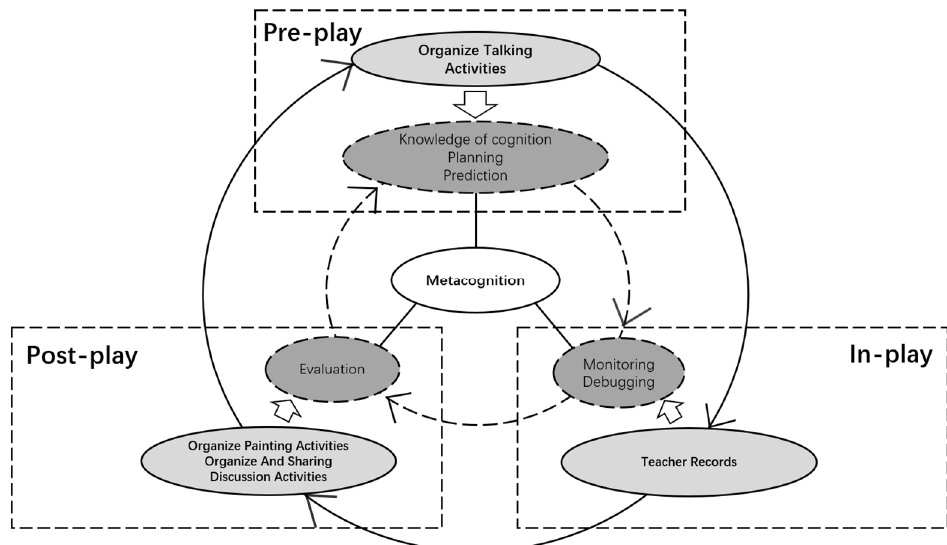
Figure 1. The framework of the Circling Curriculum for Metacognition Training. There are two circles. Circle one shows the three dashed arrows form the Circling for children’s operation, and the dashed circle is the metacognitive skills used by the children in the corresponding session. Circle two: the solid arrows form the Circling for the teacher’s operation, and the solid circle is the teacher’s educational purpose in the corresponding session. The teaching strategies for each stage are depicted in Figure 1. For a detailed description of these strategies, see Appendix B. The overall framework of CCMT exhibited the following features.